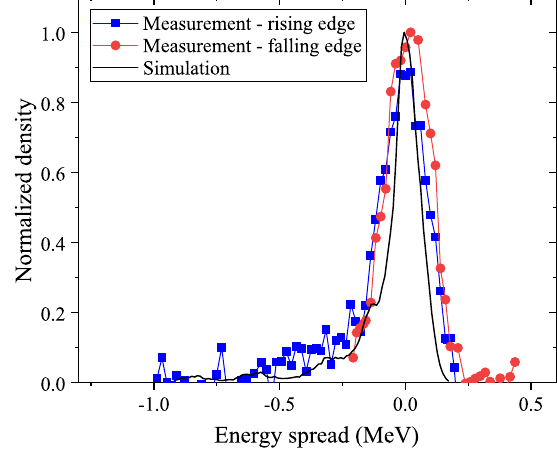
FIG. 15. Energy spread measurements with one 1.4 mm-width slit.